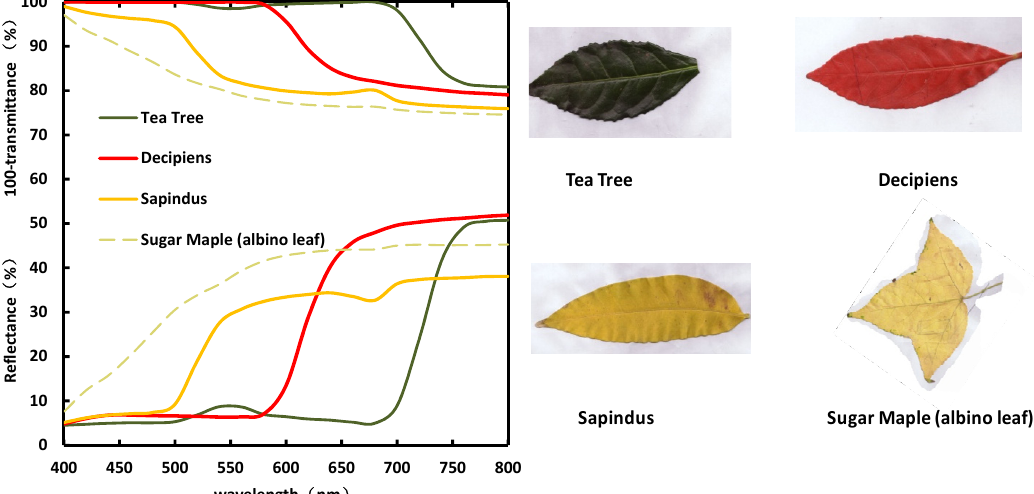
Figure 1. Reflectance and transmittance characteristics of the fresh leaf with the typical pigments from the ZJU dataset. Tee tree leaf pigment content (Cha: 78.34 μ g/cm 2 ; Chb: 35.61 μ g/cm 2 ; Cars: 12.22 μ g/cm 2 ; Ants: 1.81 μ g/cm 2 ), Decipiens (Cha: 0.6 μ g/cm 2 ; Chb: 0.55 μ g/cm 2 ; Cars: 0.05 μ g/cm 2 ; Ants: 47.21 μ g/cm 2 ), Sapindus (Cha: 1.15 μ g/cm 2 ; Chb: 1.24 μ g/cm 2 ; Cars: 0.92 μ g/cm 2 ; Ants: 0.871 μ g/cm 2 ); Sugar Maple (Cha: 0.11 μ g/cm 2 ; Chb: 0.084 μ g/cm 2 ; Cars: 0.02 μ g/cm 2 ; Ants: 0.02 μ g/cm 2 ).